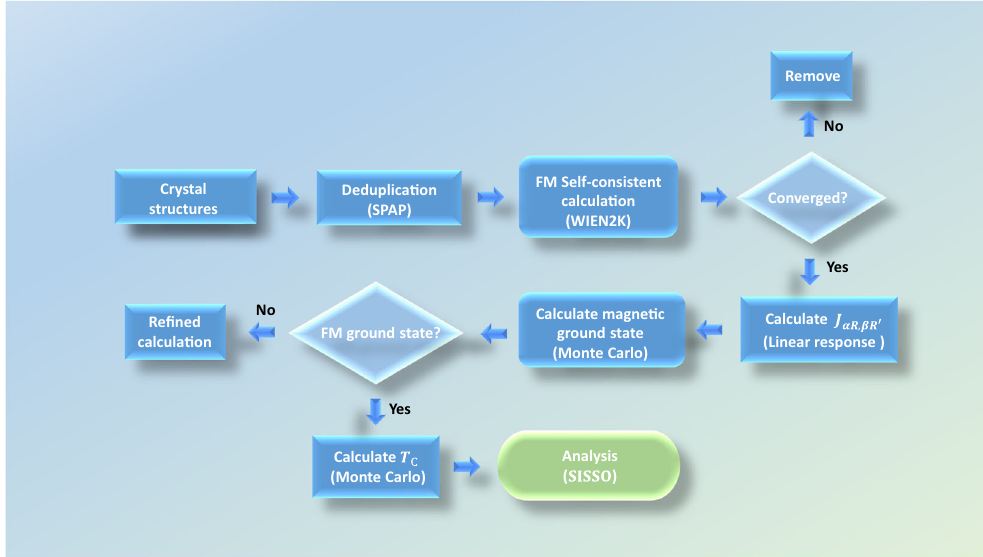
Fig. 5 The work fl ow of the high-throughput computation of the 2D magnetic materials.